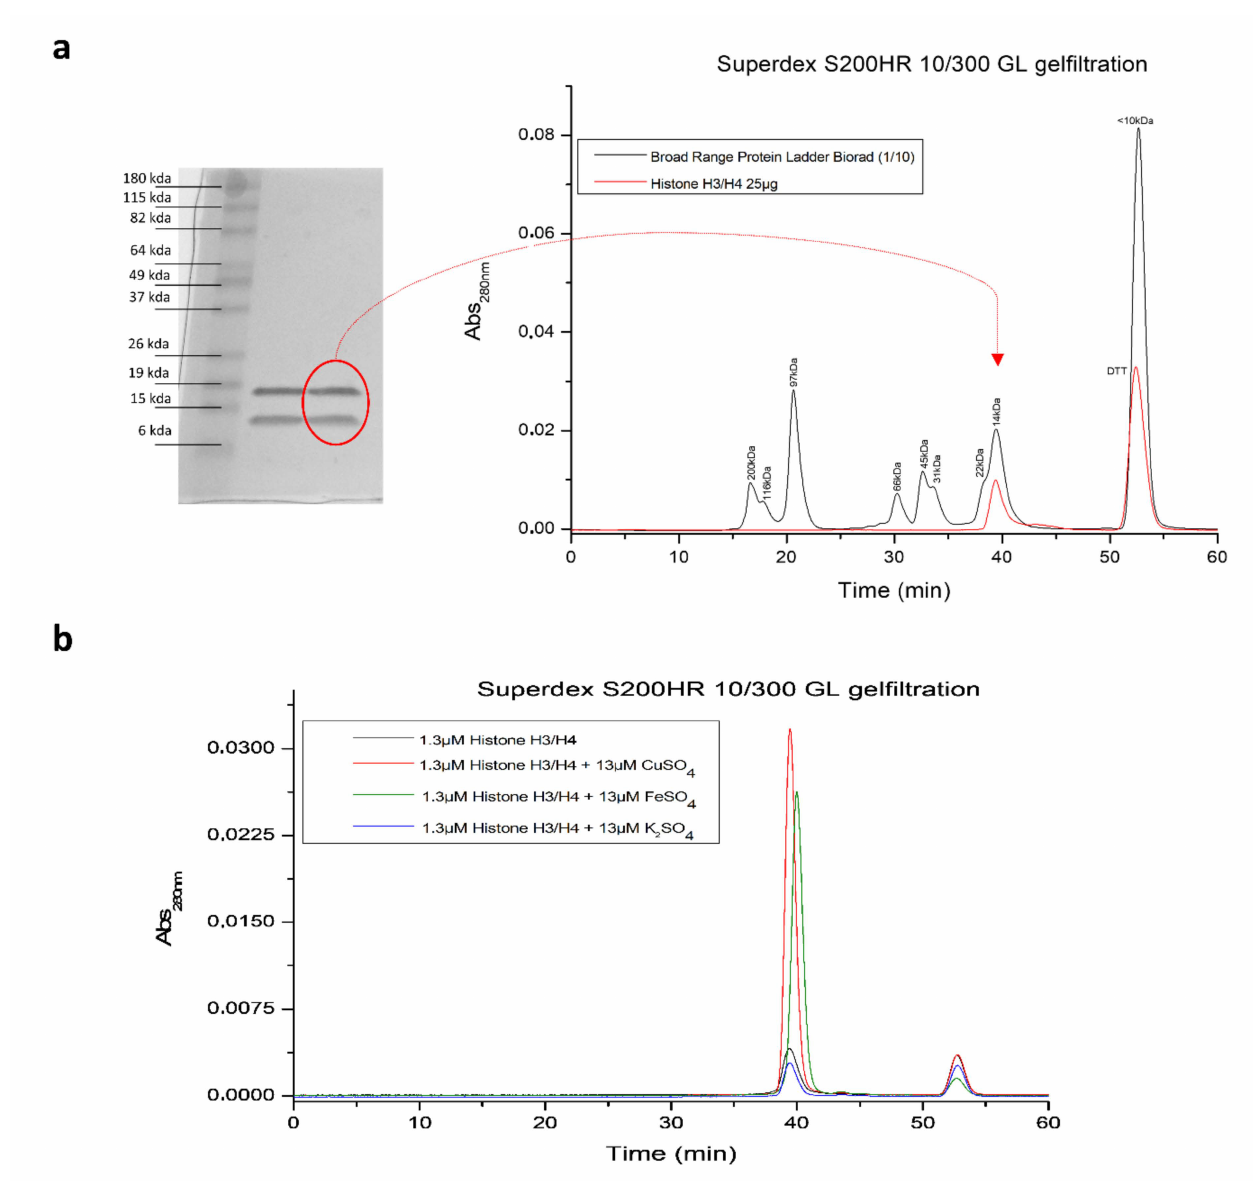
Figure 4. Purified H3-H4 tetramers display an increase in 280 nm absorbance after addition of FeSO 4 . ( a ) Purity of commercial H3-H4 tetramers was evaluated by SDS-PAGE Coomassie staining (left) and gel filtration (right). ( b ) Absorbance spectrum at 280 nm of H3-H4 tetramers incubated with a 10-fold excess of CuSO 4 (positive control), K 2 SO 4 (negative control), and FeSO 4